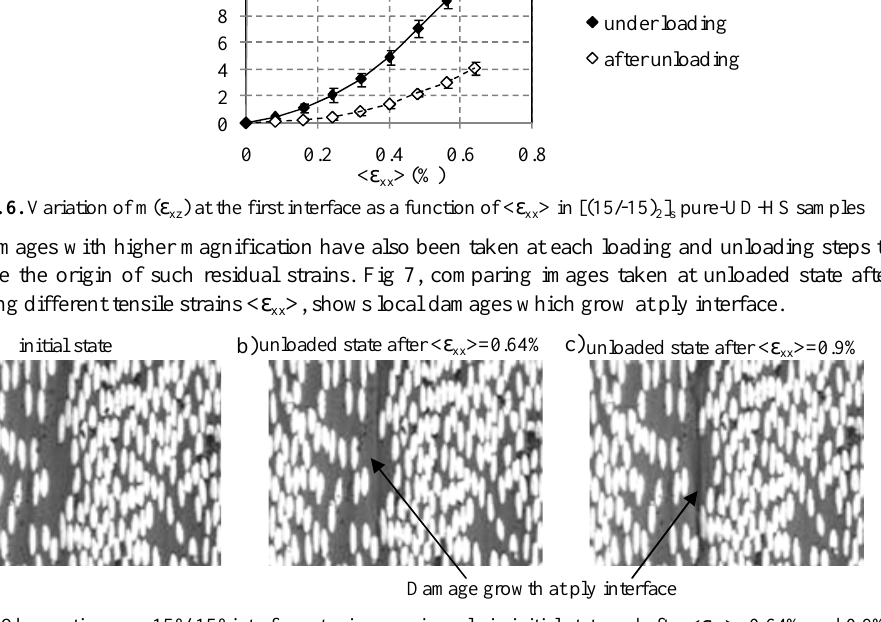
Fig. 7. Observation near 15°/-15° interface at microscopic scale in initial state and after < e xx >=0.64% and 0.9% in [(15/-15) 2 ] s pure-UD-HS samples